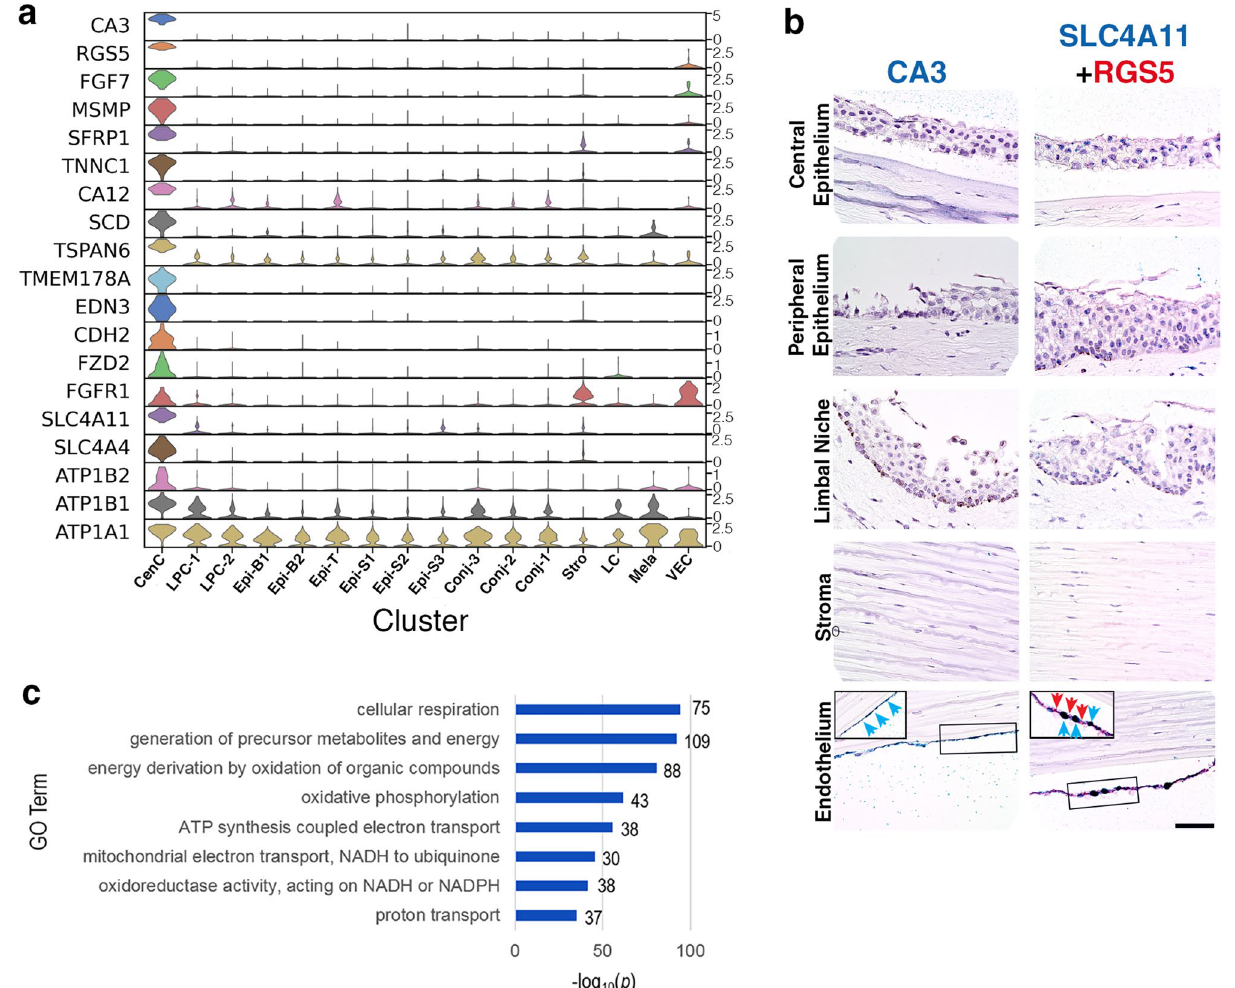
Figure 2. Molecular characteristics of corneal endothelial cells (CenC). (a) Violin plots of cluster marker gene expression. SCANPY 1.7.1 in Python was used to generate the violin plots as indicted in the "Materials and methods" (https:// pypi. org/ proje ct/ scanpy/). (b) RNAScope on human cornea of CenC specific genes CA3 , SLC4A11 , and RGS5 (scale bar: 50 uM). Insert of zoomed in selection of endothelium is outlined for SLC4A11 and RGS5 . (c) Topmost enriched GO terms (Biological Process) of genes up-regulated in CenC compared to other clusters. The number of overlap genes are indicated next to each Mapping the location of subtypes of epithelial cells in human cornea. The epithelial cell clusters were defined by high expression of known epithelial markers SFN , KRT5 , TACSTD2 , and S100A14 ; they rep- resent the most diverse cell types with eleven clusters identified (Fig. 1c, Fig. 4a,b; heatmap: Fig. S4) 25–28 . Fur- thermore, three clusters represent conjunctival epithelial cells (Conj-1,2,3) and eight clusters represent corneal epithelial cells (LPC-1,2,Epi-B1,B2,T,S1,S2,S3). Analyses of epithelial sub-cluster marker genes revealed both uniquely expressed and shared genes among sub-sets of clusters (Fig. 4a). The observation of both distinctive and highly overlapping gene expression patterns is in agreement with some epithelial cells having distinct func- tions, while overlapping genes is consistent with the continuous epithelial structure from basal to superficial layer and from limbal to central cornea region 29 . Corneal epithelial cell development progresses from the limbus into the periphery and then the central region both laterally and vertically. PAGA and pseudotime analyses using LPC-1 as time 0 suggest that there are two major trajectories of corneal epithelial differentiation, one towards superficial cells (Epi-S1,2,3) and one towards basal cells (Epi-B1,2,T) (Fig. 4c–e). Molecular signature of limbal progenitor cells (LPC), transiently amplifying cells, and other basal epithelial cells. One of the characteristics of cornea epithelial cells is the ability to continually self-renew. Previous bulk transcriptomics of peripheral cornea and limbal niche report upregulated genes for cell cycling and proliferation in the cornea which is reflective of maintaining epithelial turn over 6 . The limbal epithelial stem cells (LESCs) reside within the basal layer palisades of Vogt and have been challenging to characterize within the heterogene- ous limbal niche.